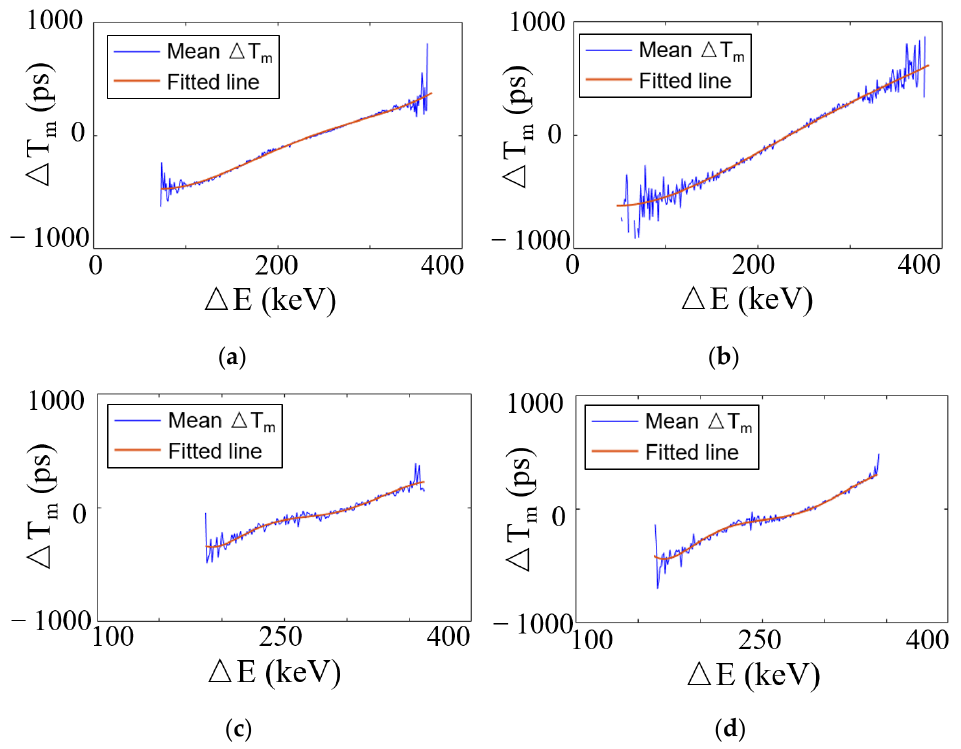
Figure 9. Relationships and fitted curve of mean ∆𝑇 𝑚 and ∆𝐸 of ( a ) SiPM 1 of dual-ended readout, ( b ) SiPM 1 of side dual-ended readout, ( c ) SiPM 1, and ( d ) SiPM 3 of triple-ended readout.